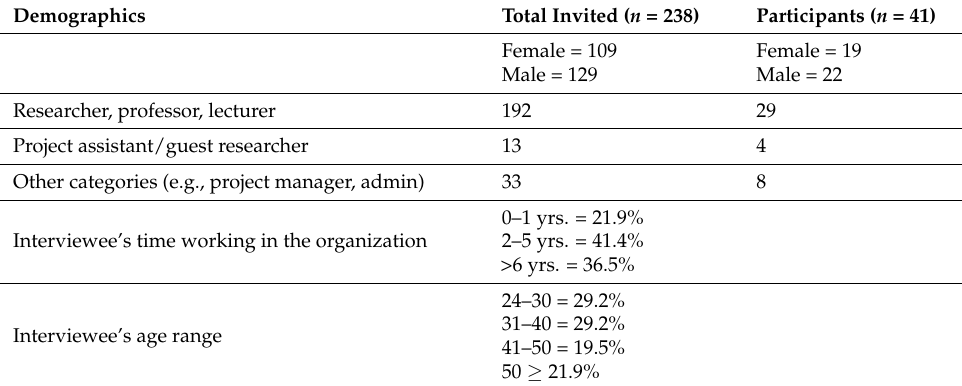
Table 1. The participants’ demographics and professions.